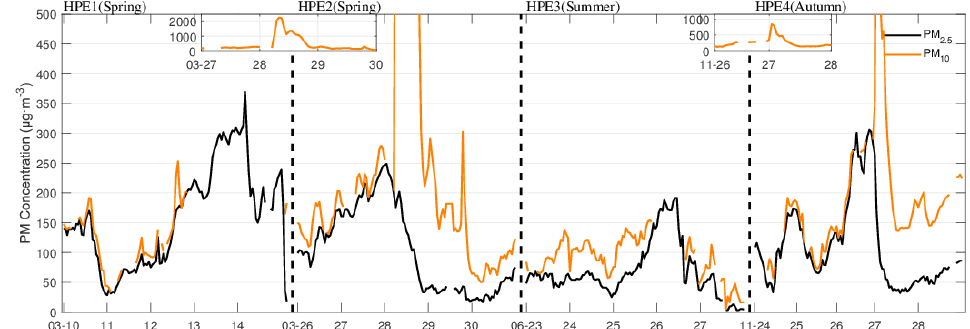
Figure 1. Diurnal distributions of PM 2.5 and PM 10 concentration during heavy pollution episodes (HPE1, 2, 3, and 4) in Beijing in 2018.